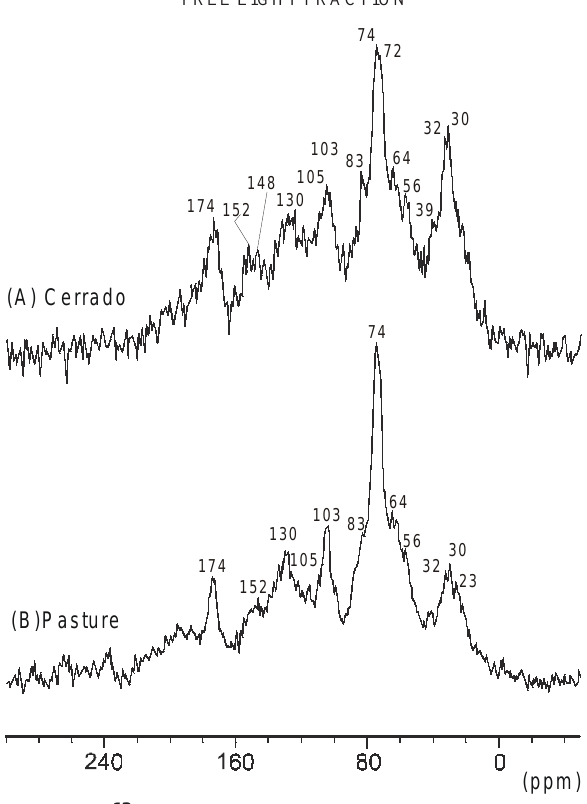
Figure 1. 13 C-CPMAS-NMR of the free light fraction (F-LF) of SOM from samples in the (A) cerrado and (B) pasture plots.